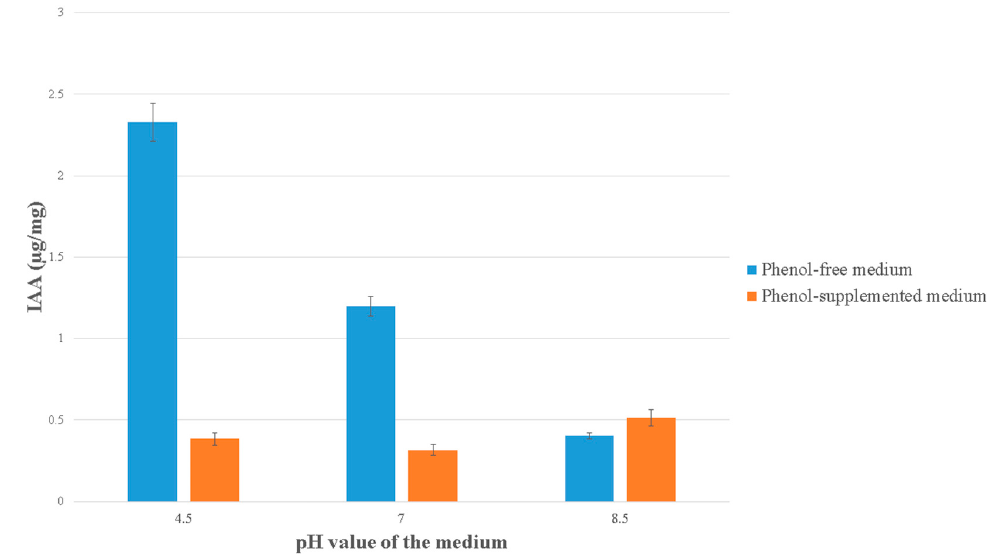
Figure 5. Bacterial indole-3-acetic acid (IAA) production in LB medium with different pH values: phenol-supplemented medium—LB medium with added phenol (500 mg L − 1 final concentration); phenol-free medium—LB medium without phenol. Data represent the mean ± SE ( n = 3).